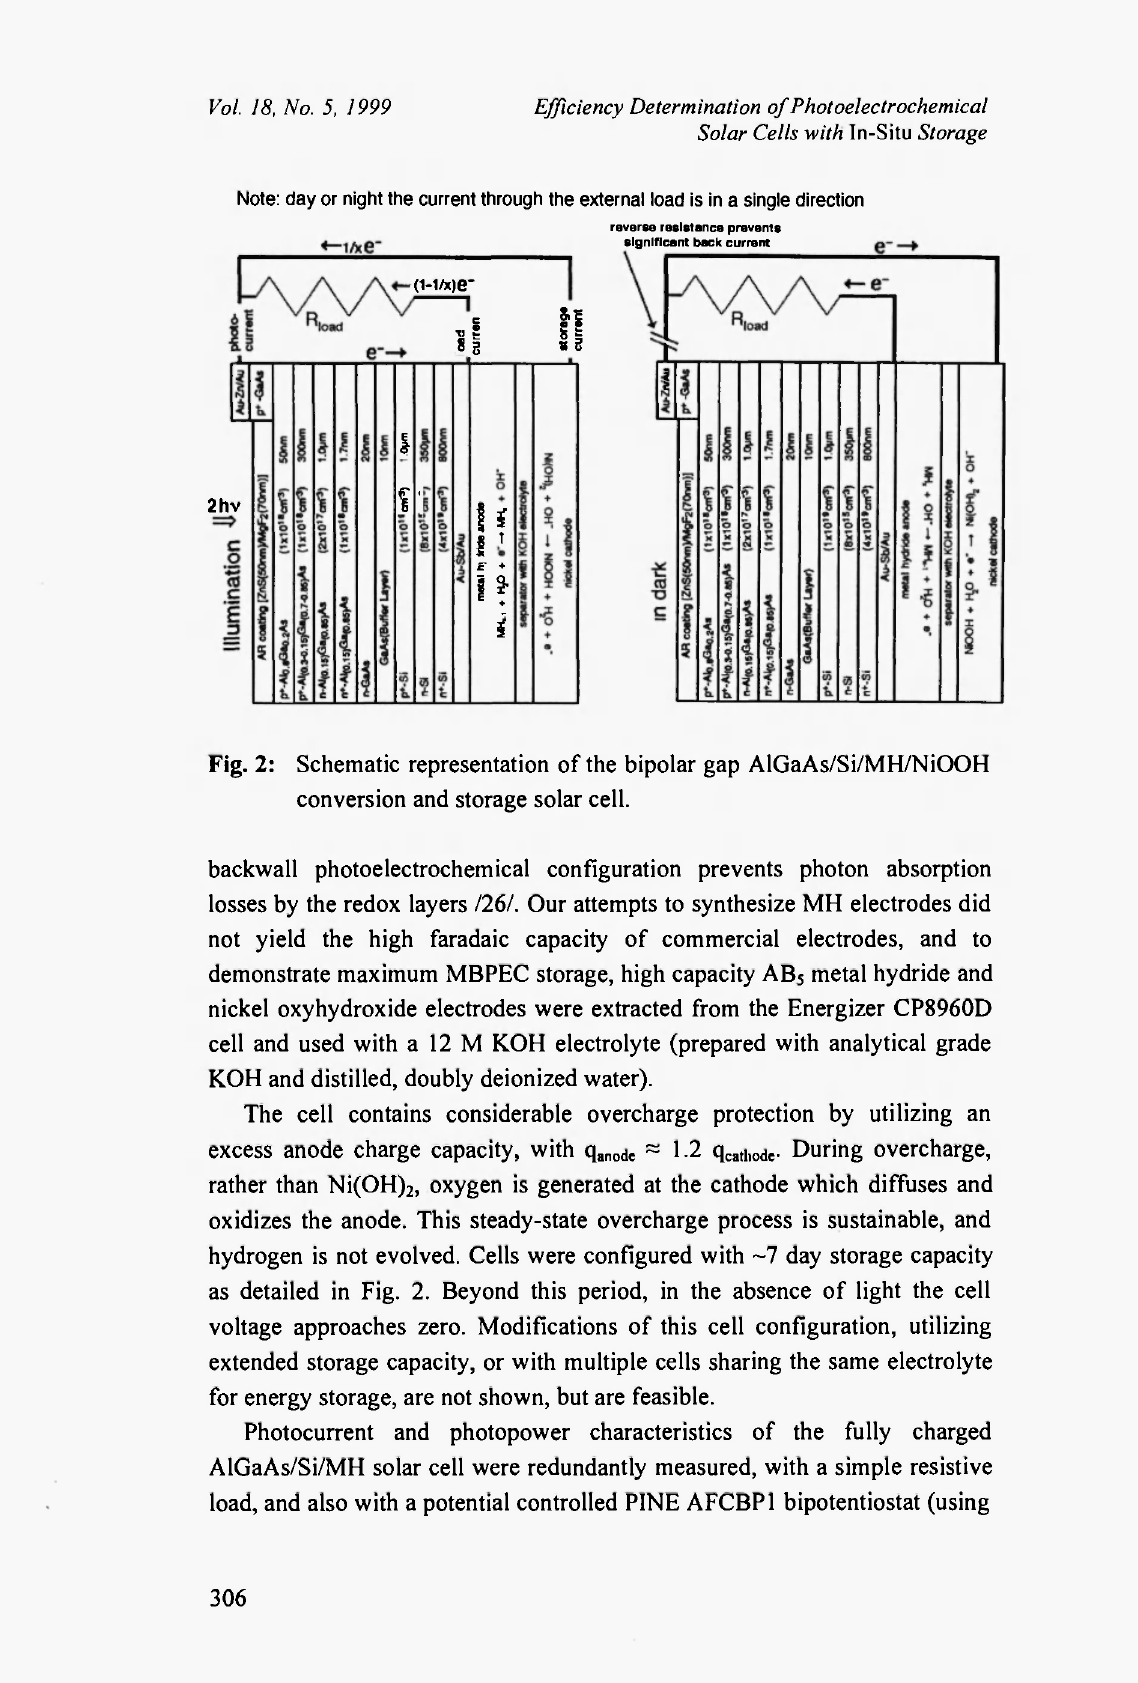
Fig. 2: Schematic representation of the bipolar gap AlGaAs/Si/MH/NiOOH conversion and storage solar